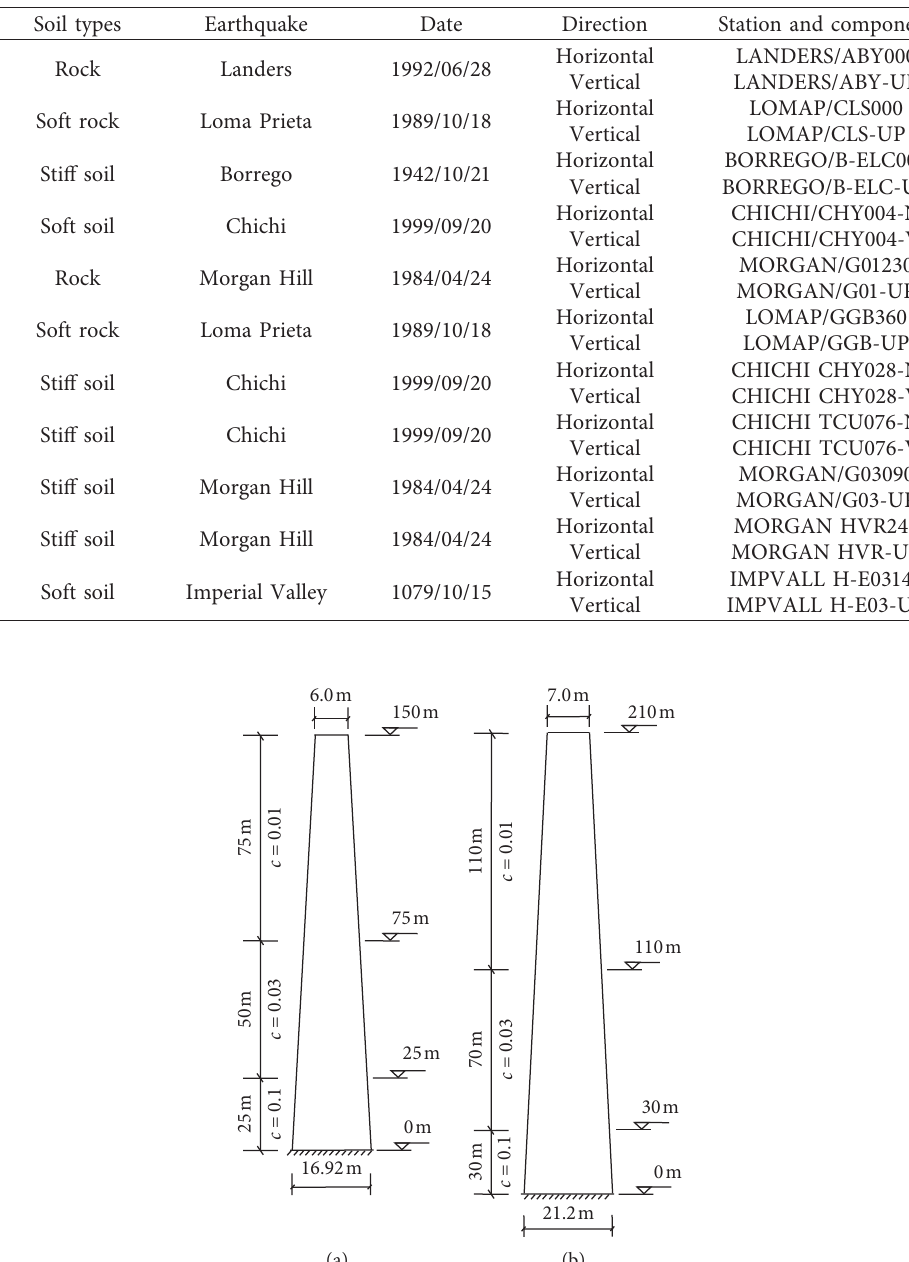
Table 1: Earthquake records used.